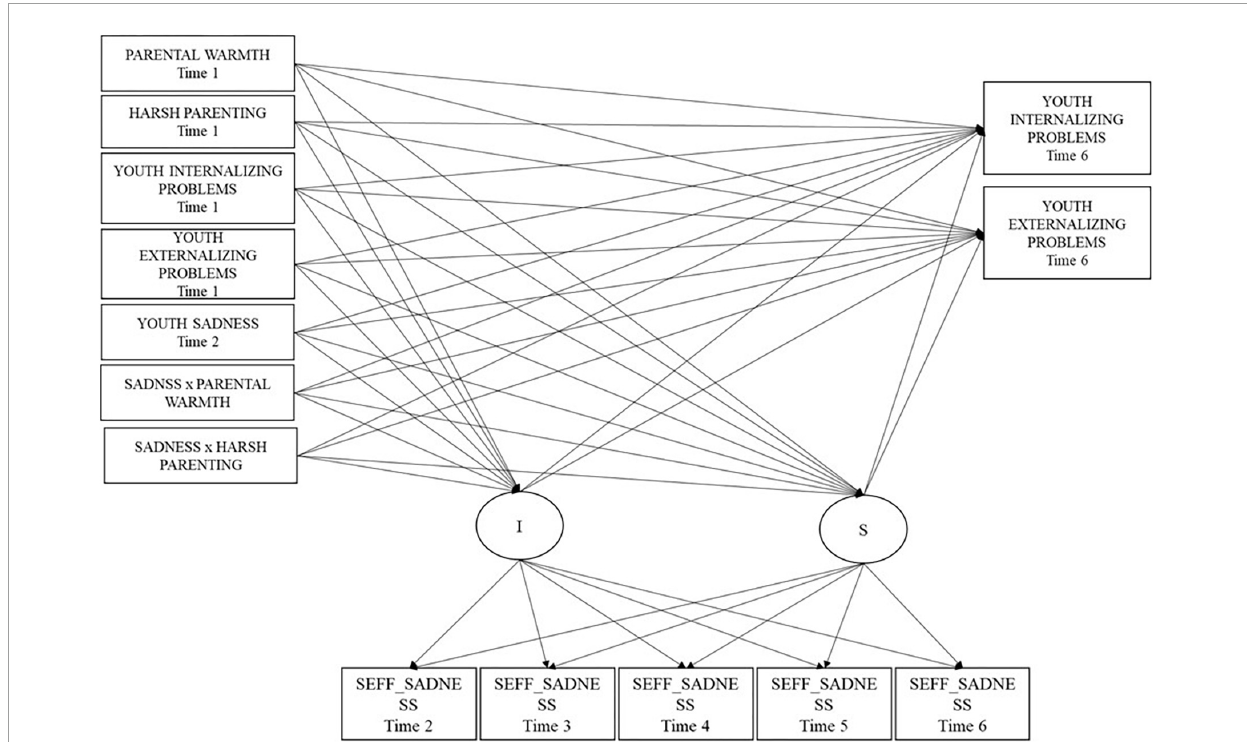
FIGURE3 Conditional multi-group latent growth curve model 2 for self-efficacy about sadness regulation for the two cultural groups. We also estimated the correlations within the time among predictors and outcomes and the effect of covariates (youths’ gender and parents’ educational level. SEFF_Sadness refers to self-efficacy in sadness